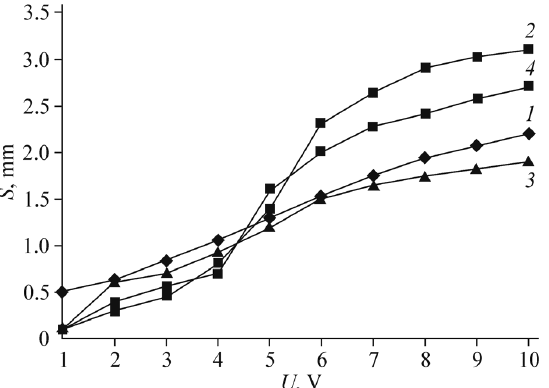
Figure 17. Dependencies of the actuator displacement amplitude against sinusoidal applied volt- age (the frequency is 1 Hz) for the electrode-membrane combinations: (1) graphene/MF-4SK; (2) Pt/Nafion (125- μ m thick); (3) Pt/MF-4SK (120- μ m thick); (4) Pt/MF-4SK (290- μ m thick). Reproduced from [40] with permission from Springer Nature. Copyright 2020.